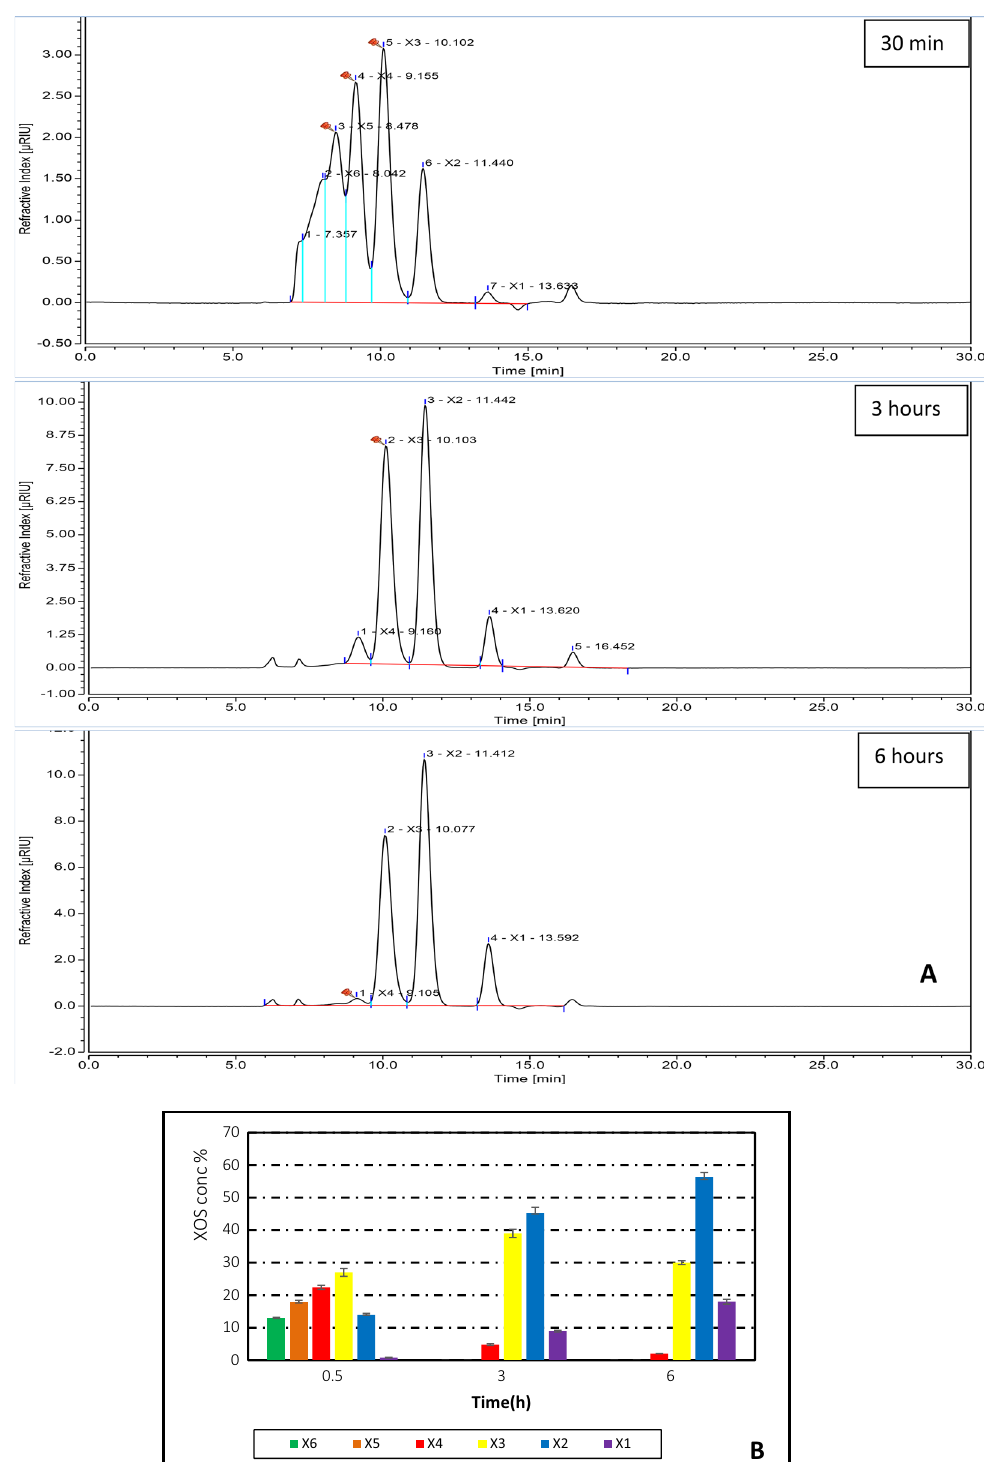
Figure 7. ( A ): HPLC analysis of xylo-oligosaccharides (XOS) of beechwood xylan with purified xylanase enzyme produced by Paecilomyces variotti ; ( B ) effect of reaction time on enzymatic hydrolysis and relative concentrations of XOS. * Xylose (X1), xylobiose (X2), xylotriose (X3), xylotetraose (X4), xylopentaose (X5), xylohexose